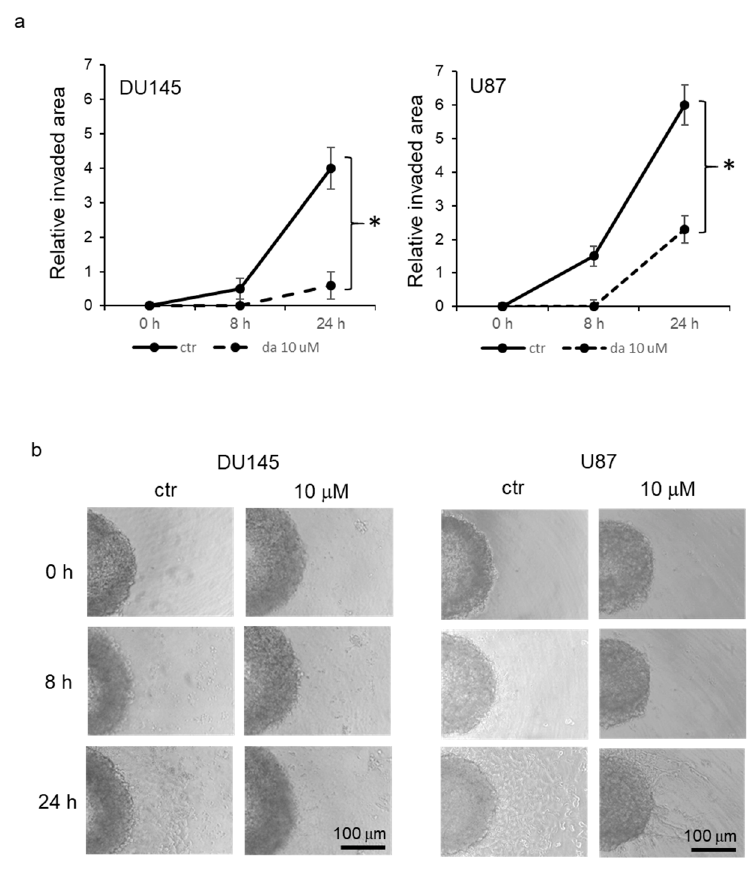
Figure 5. Inhibition of cell dissemination in spheroid. ( a ) Mean relative invaded area in DU145 and U87 spheroids evaluated 8 and 24 days after plating onto collagen-coated surface. The values represent the mean of five different measurements (±standard deviation) of spheroids treated or not with 10 μ M dasatinib. * p < 0.01 between indicated points according to Student’s t test. ( b ) Representative images acquired by phase contrast microscopy (100× magnification) of DU145 and U87 cells at 0, 8, and 24 h after plating in the presence or not of 10 μ M dasatinib.